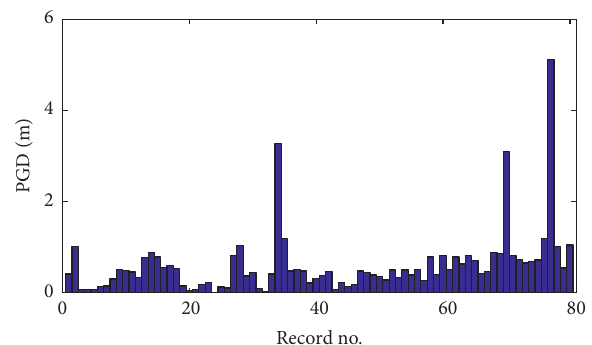
Figure 5: PGD distribution of 80 ground